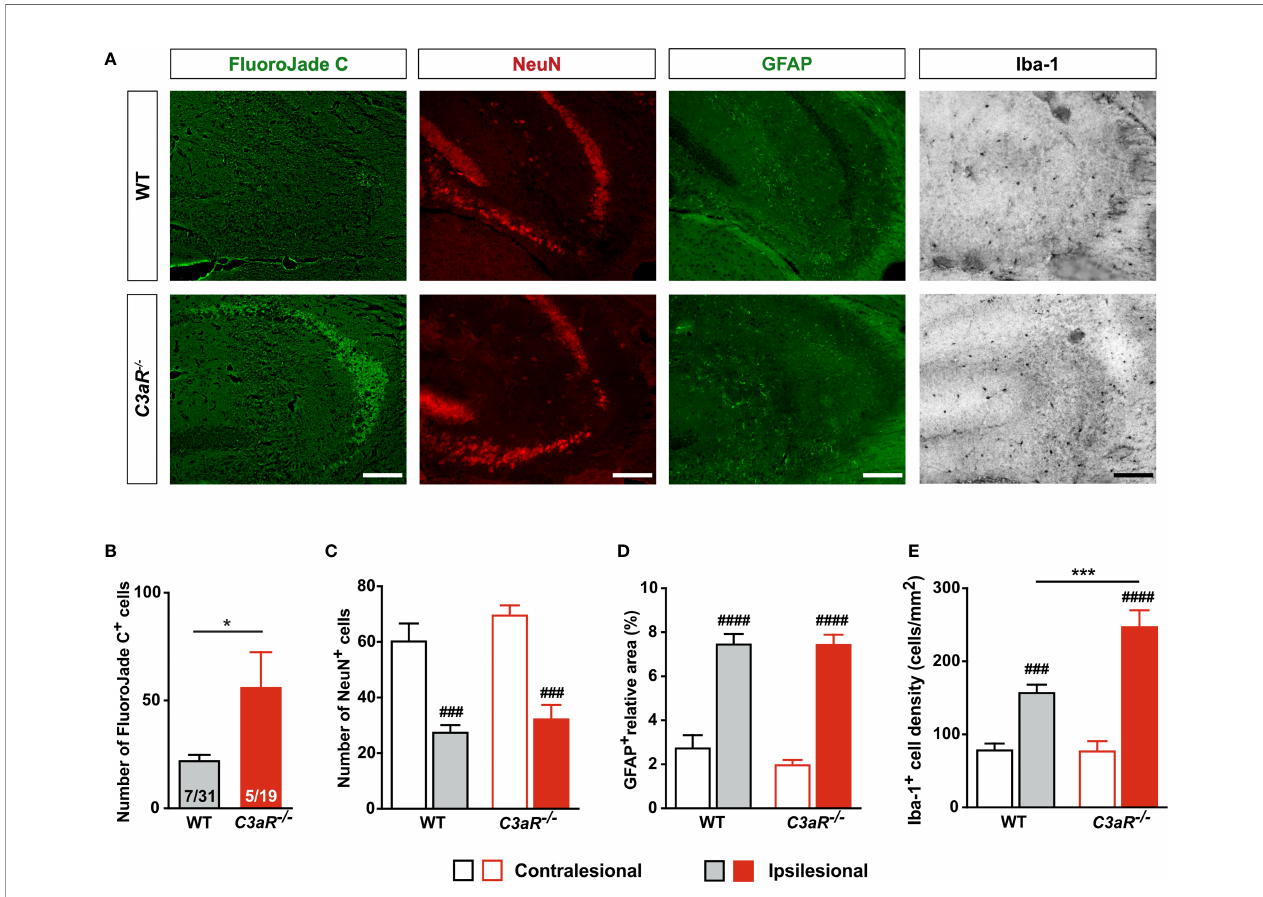
FIGURE 4 | HI-induced neurodegeneration is increased in mice lacking C3aR. (A) Representative images of ipsilesional CA3 stained with FJC and antibodies against NeuN, GFAP and Iba-1 7 weeks after HI induction. Scale bar = 50 µm. (B) Number of FJC + cells and (C) NeuN + cells, (D) relative GFAP + area, and (E) density of Iba-1 + cells in CA3 of WT and C3aR – / – mice. IL, ipsilesional; CL, contralesional; * P < 0.05; *** P < 0.001 vs WT; ### P < 0.001, #### P < 0.0005 vs contralesional. Data were analyzed by two-tailed unpaired t test (B) or two-way ANOVA and Tukey ’ s posthoc test (C – E) . Numbers in the bars in (B) are number of positive mice/total number of mice. (C – E) n = 7 (WT) and 5 ( C3aR – / – ). Values are mean ±